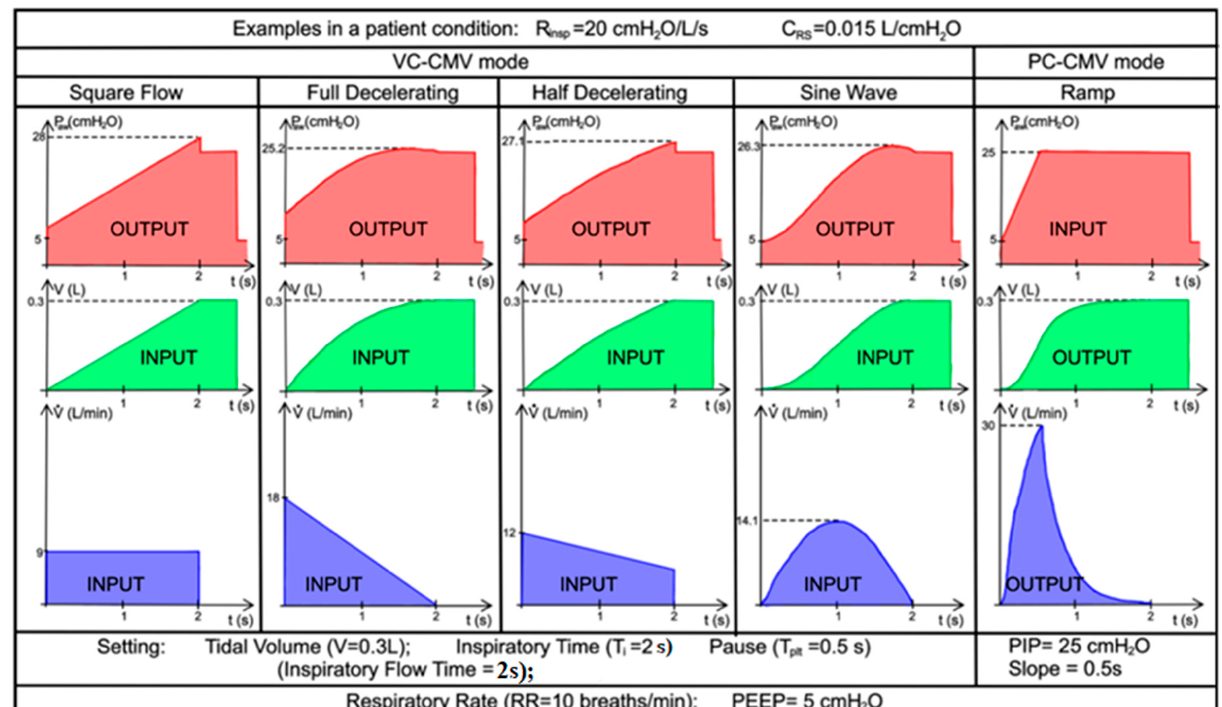
Figure 20. Case 1. Real-life quantitative data of flow, volume, and pressure waveforms on various patterns of inspiratory flow, adapted from [46].